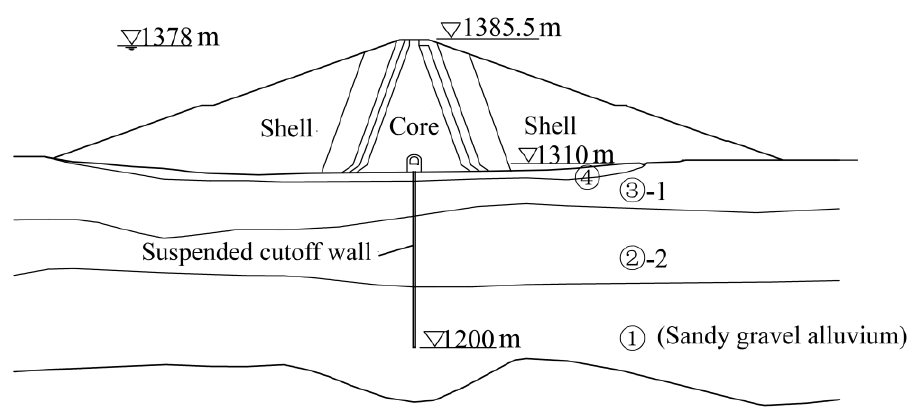
Figure 1. Strata profile at the dam site: ①, ② -2, ③ -1, and ④ denote the strata in the foundation .